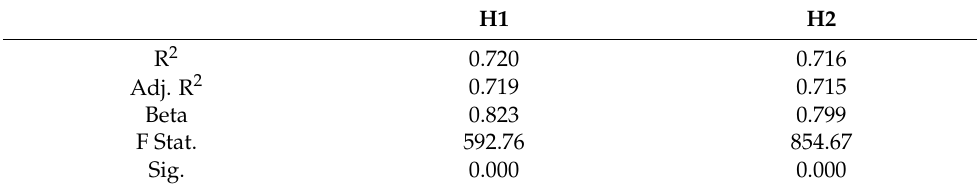
Table 17. Regression Results (Testing of